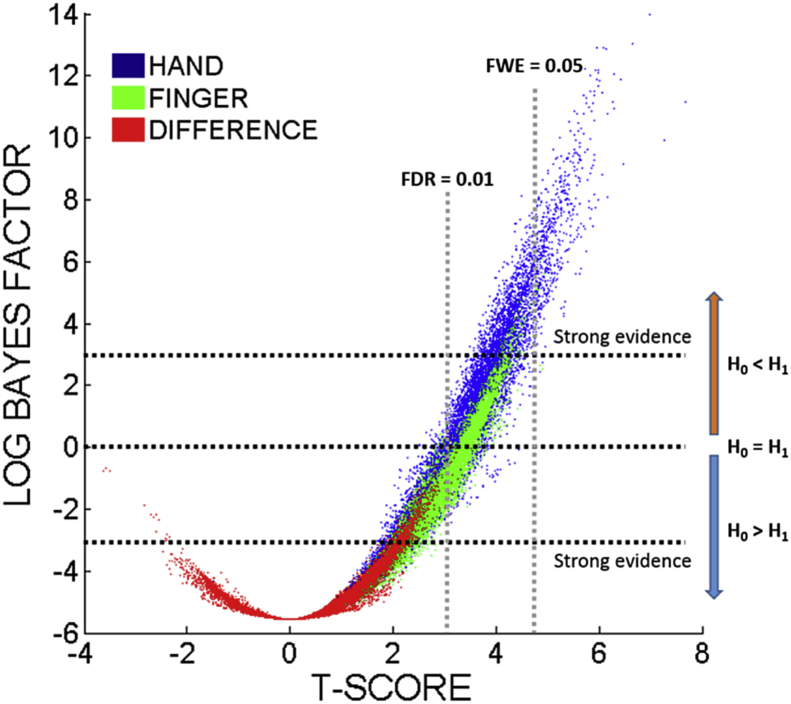
Scatter graph plotting t-statistics against log Bayes Factors in VLSM analyses of hand and finger imitation scores, and of the difference between them for each of the tested voxels. For comparison, we plot the threshold after correction for multiple comparisons using both FDR = 1% (used in the VLSM analyses), and the more stringent FWE = 5% (calculated using permutation thresholding).